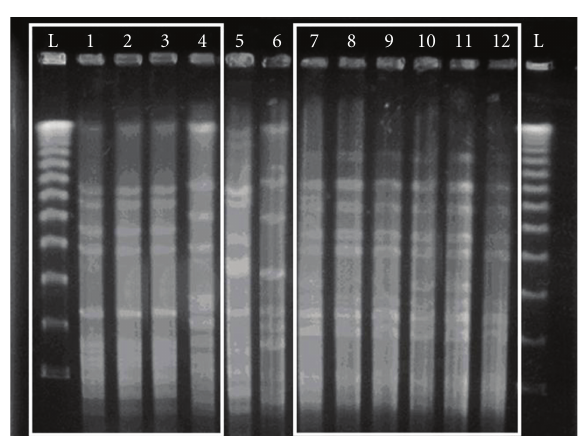
Figure 1: Pulse field gel electrophoresis (PFGE) of di ff erent isolates of S. aureus; the first and last lanes correspond to the DNA ladder; lanes 1–4 correspond to strains collected from lesional skin (1), nose (2), healthy skin (3) of an atopic patient (patient 16), and his father (4); lanes 7–12 show similar strains isolated from lesional skin, nose, healthy skin of an atopic patient (patient 26) and related mother, father, and